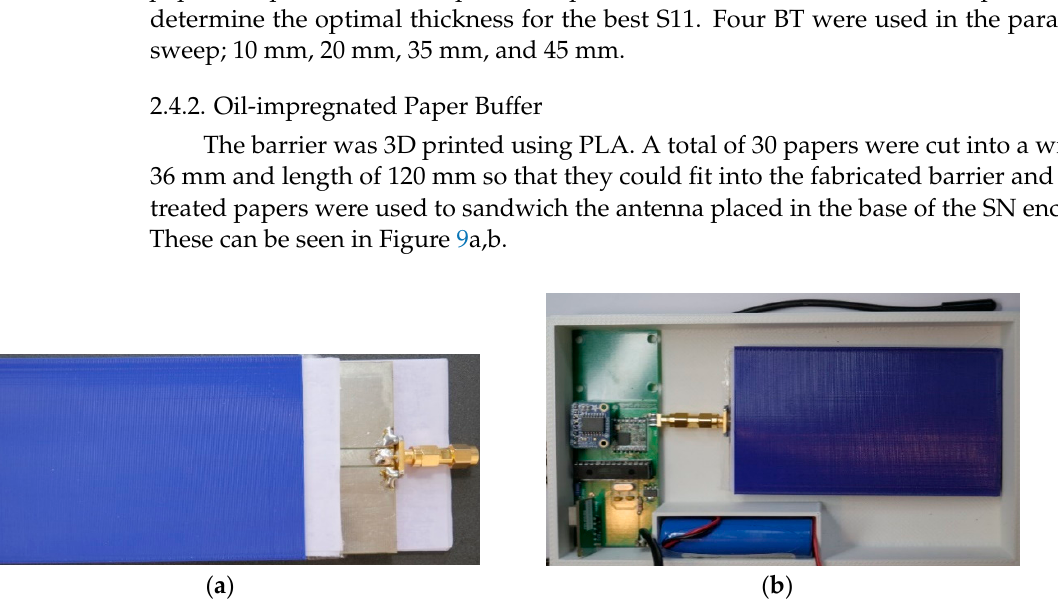
Figure 9. ( a ) Oil Treated paper, barrier, and braid antenna ( b ) antenna barrier inside enclosure with printed circuit boards (PCB) of sensor node (SN).